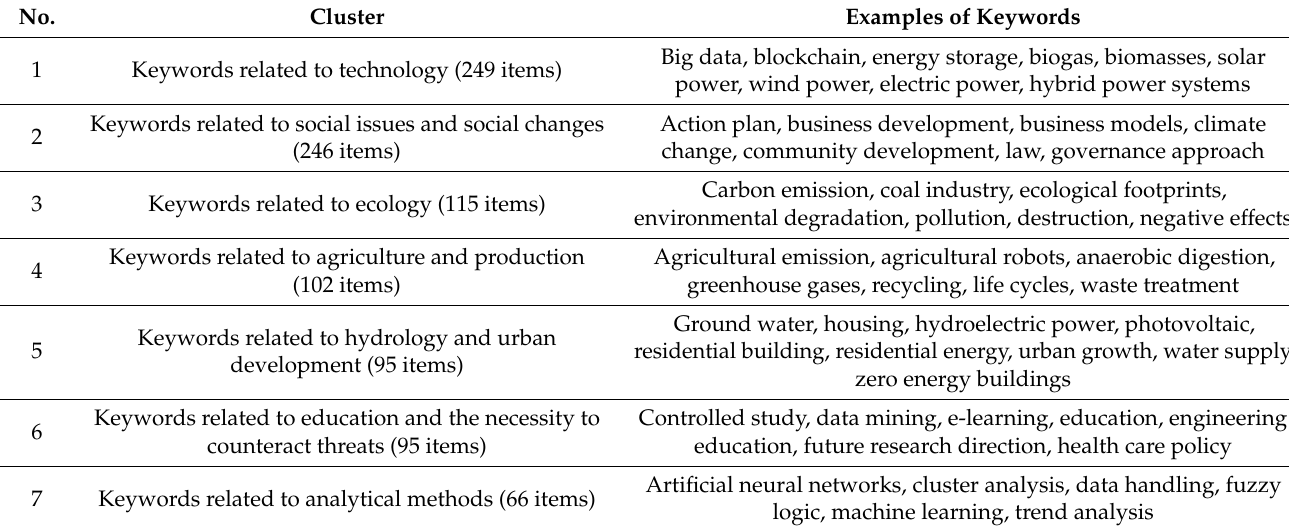
Table 4. Characteristics of